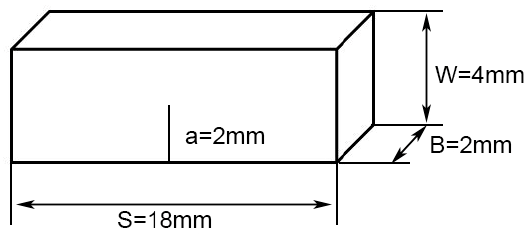
Figure 2. Single edge notched bend specimen used in fracture toughness tests.